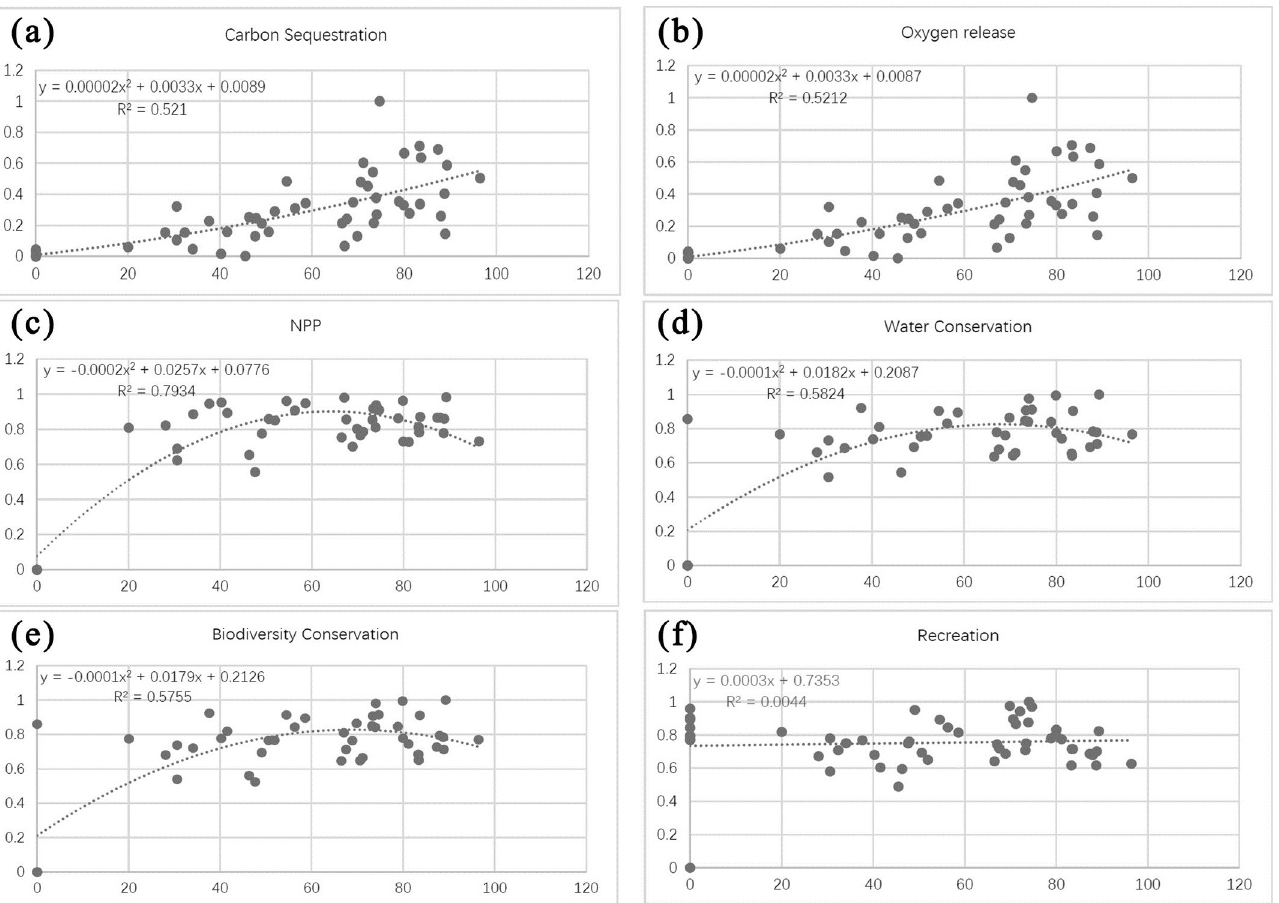
Fig 12. Relationships between the forest sprawl index (CONTAG) and different ecosystem service functions. Plots show the relationships between CONTAG and (a) carbon sequestration capacity, (b) oxygen release capacity, (c) NPP capacity, (d) water conservation capacity, (e) biodiversity conservation capacity, and (f) recreational